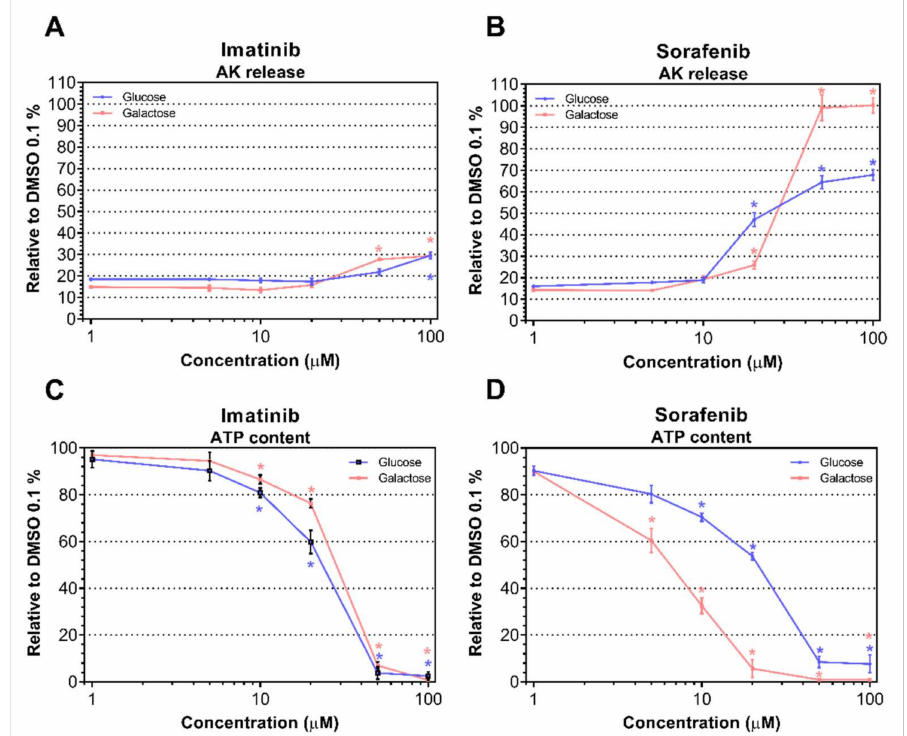
Figure 1. Membrane toxicity and intracellular ATP content in H9c2 cells exposed to imatinib and sorafenib. ( A , B ) Membrane toxicity was assessed by the release of adenylate kinase (AK) after drug exposure for 24 h under glucose and galactose media with imatinib ( A ) and sorafenib ( B ). Data are expressed as % AK release in the presence of 0.1% Triton X (set at 100%). ( C , D ) Intracellular ATP content after drug exposure for 24 h under glucose and galactose media with imatinib ( C ) and sorafenib ( D ). Data represent the percentage of ATP content in the presence of 0.1% DMSO (set at 100%). Data represent the mean ± SEM of at least four independent experiments. * P < 0.05 versus 0.1% DMSO